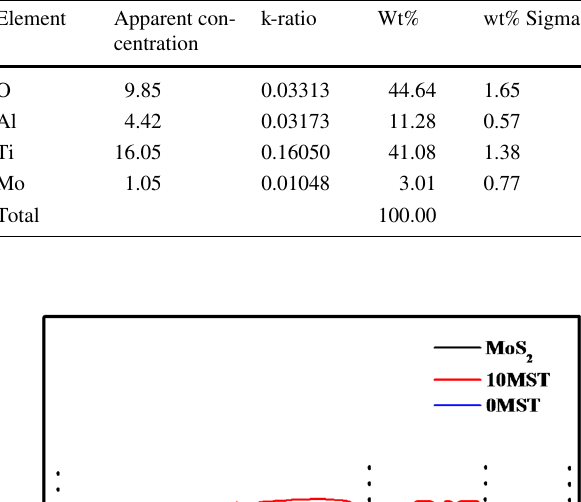
Table 1 Elemental data obtained for the EDX point analysis Element